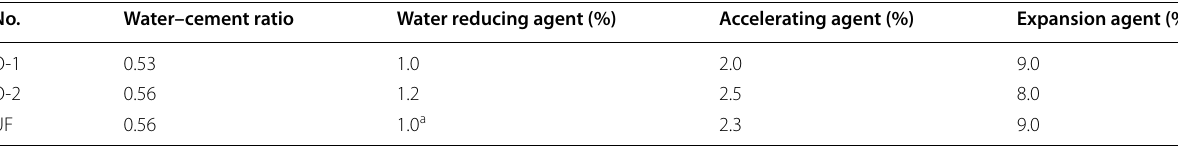
Table 10 Formulas of the cement grouting material based on different methods